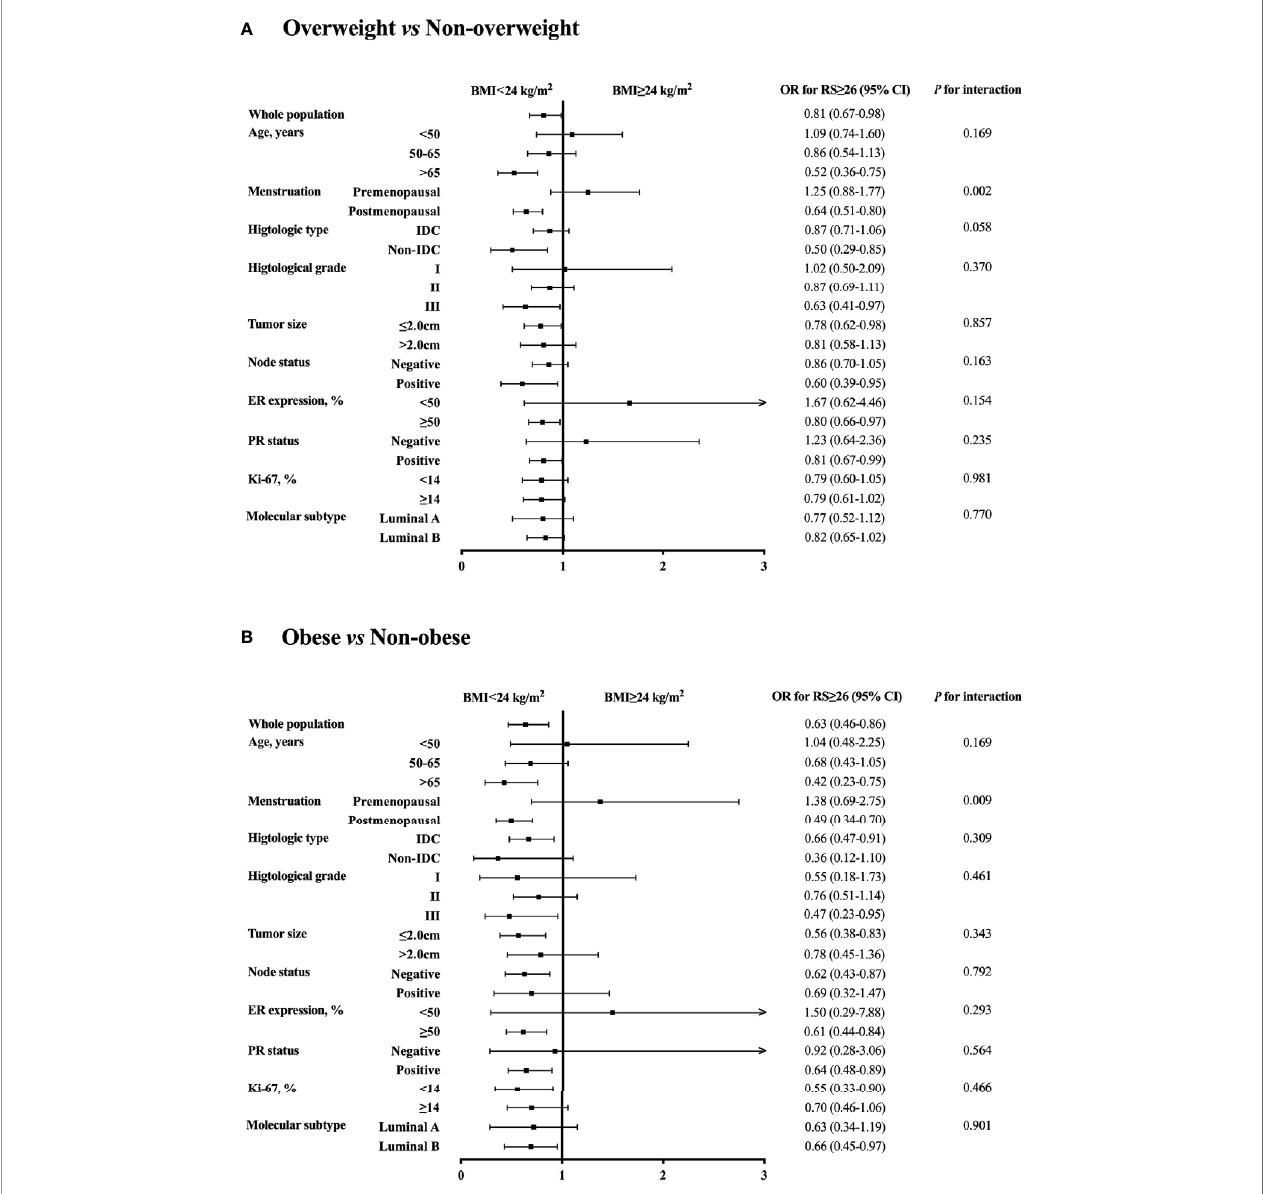
FIGURE 2 | Subgroup analysis of interacted factors with BMI and 21-gene RS. The odds with 95% CI for RS ≥ 26 were compared between (A) overweight vs non- overweight, and (B) obese vs non-obese patients by each subgroup. BMI, body mass index; OR, odds ratio; RS, recurrence score; CI, con fi dence interval; IDC, invasive ductal carcinoma; ER, estrogen receptor; PR, progesterone